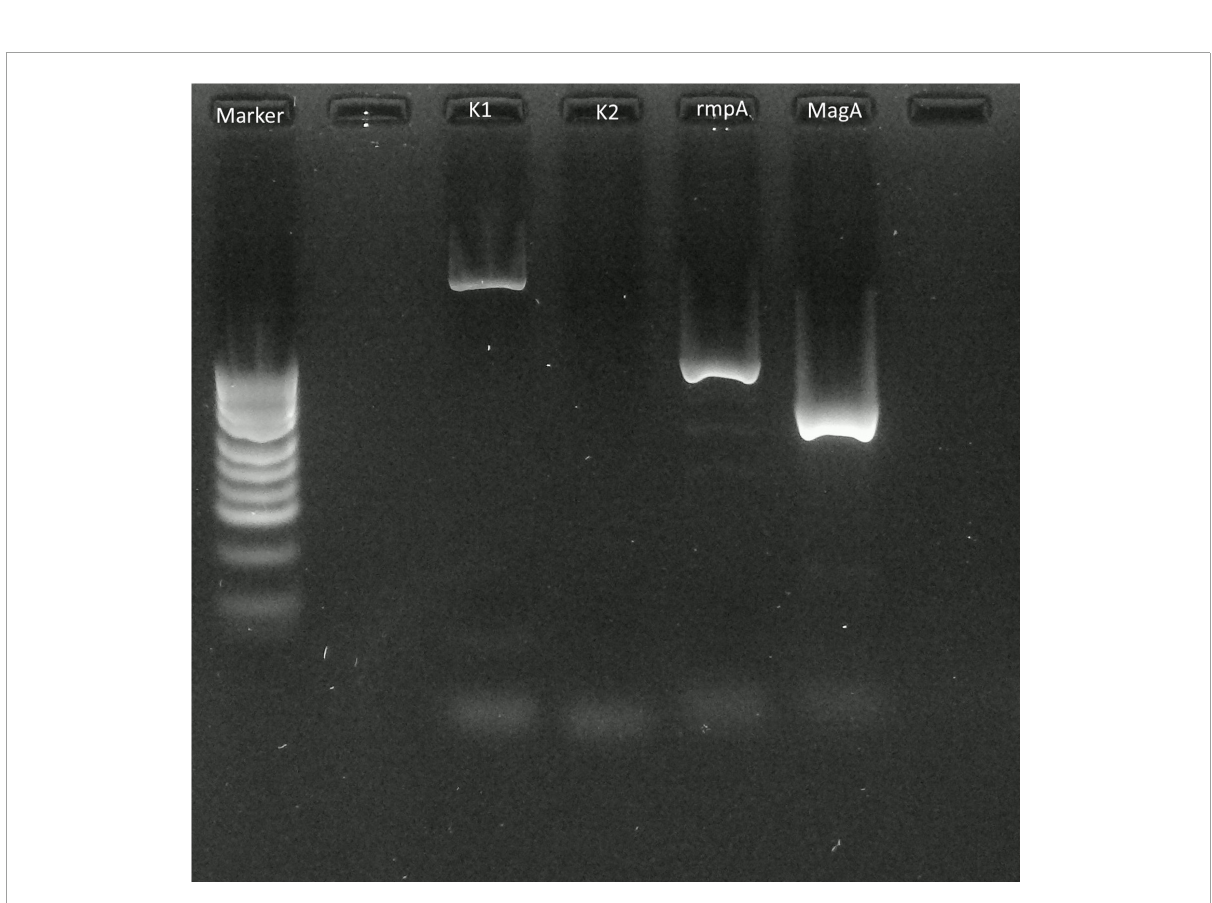
FIGURE2 Polymerase chain reaction (PCR) applied to the pus of the liver abscess. PCR with extracted DNA from the pus of the abscess revealed amplification of the Klebsiella pneumoniae serotype K1 specific locus (wzyKPK1), rmpA, and magA fragments that were detected by electrophoresis on 2.0%